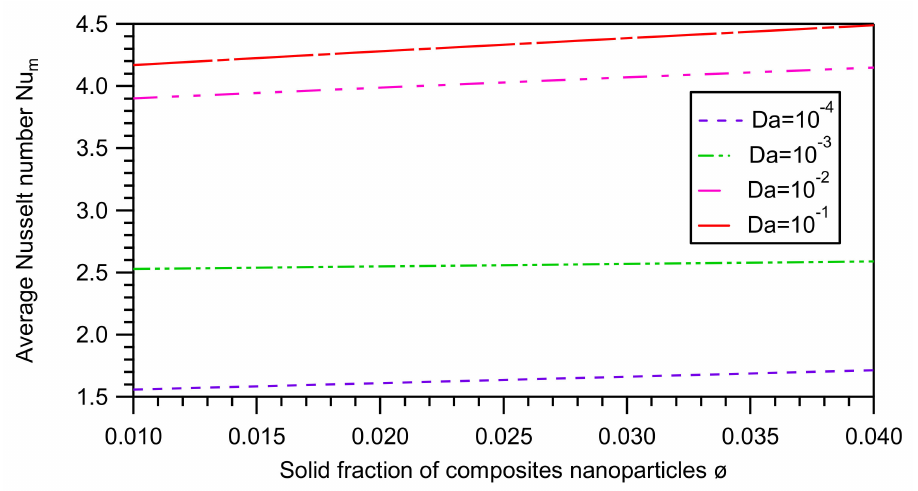
Figure 12. The average Nusselt number Nu m according to solid fraction of composite nanoparticles ϕ for di ff erent values of Darcy number (Da = 10 − 4 , 10 − 3 , 10 − 2 and 10 − 1 ) with Ra = 10 5 , Ha = 15, AR = 0.3, ω = 0 and q ∗ = 1.